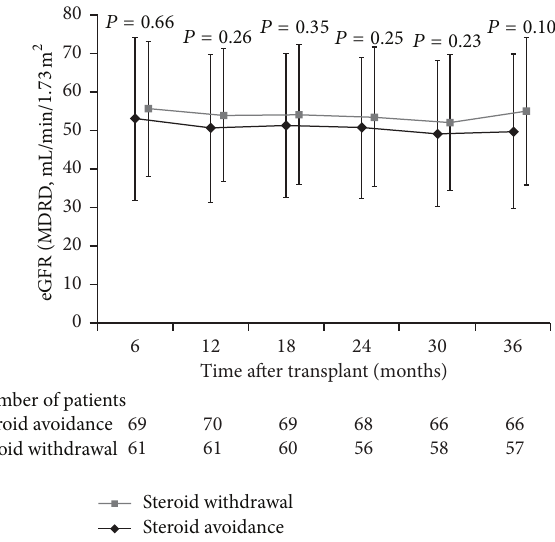
Figure 3: Estimated GFR (MDRD) during months 6 to 36. Values are shown as mean (SD). GFR: glomerular filtration rate; MDRD: Modification of Diet in Renal Disease; SD: standard